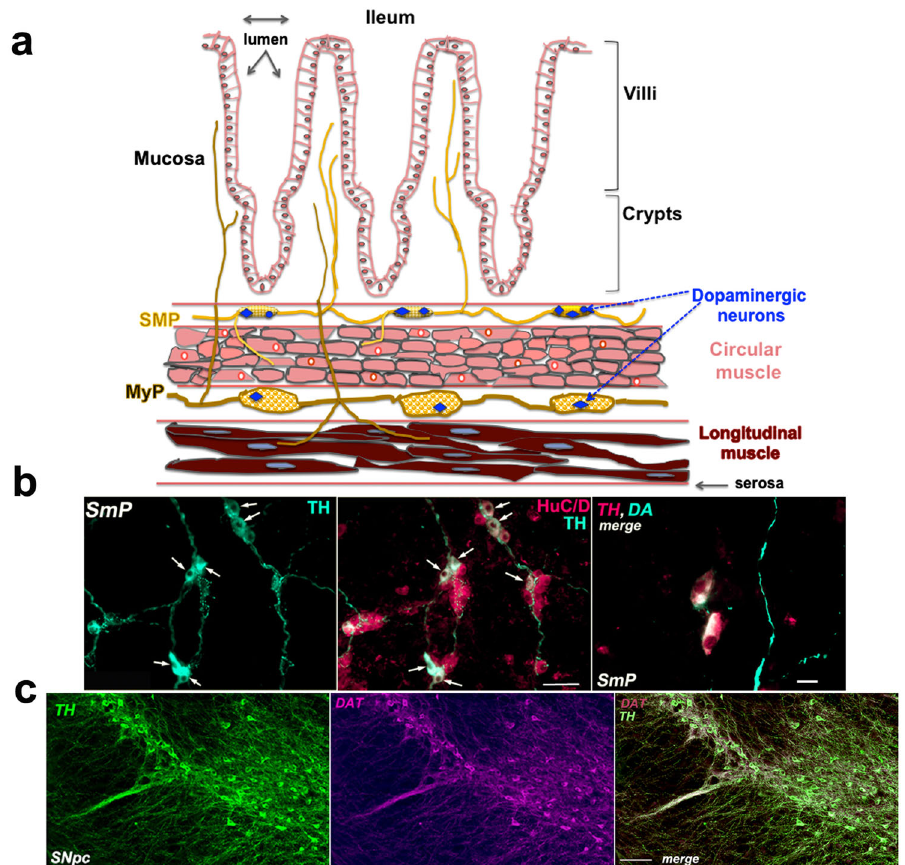
Fig. 1 Contrasting architecture of enteric dopaminergic neurons within enteric ganglia that are organized into two plexuses and of nigral dopaminergic neurons within layers of the SNpc. a Longitudinal section of gut through the ileum encompassing from the lumen to the serosa: the mucosal epithelial layer with villi and crypts, the submucosal layer with the ganglionic chains of submucosal (SMP) neurons (yellow), the layers (in cross-section) of circular smooth muscle fi bers (pink, brick-shaped), the ganglionic chains of myenteric (MyP) neurons (brownish yellow), the layers of longitudinal smooth muscles (dark red). Dopaminergic neurons within the ganglia of both plexuses are highlighted (blue stars). Note how the chains of submucosal ganglia are contiguous with the mucosa. b Fluorescence immunocytochemistry of representative whole mounts of SmP from adult mouse, displaying the dopaminergic neurons (left panel, identi fi ed with TH antibodies, green fl uorescence, white arrows) and as a subset (middle panel, merged image, white arrows) of all the neurons identi fi ed with HuC/D antibodies, (magenta fl uorescence); calibration bar: 70 microns. Right panel: magni fi ed view of two dopaminergic neurons identi fi ed with both TH and DA antibodies (merged magenta and green fl uorescences); calibration bar: 16 microns. This image is provided by Dr Alcmène Chalazonitis. c Fluorescence immunocytochemistry of a representative section of adult mouse midbrain through the Substantia Nigra with dopaminergic neurons identi fi ed with TH antibodies (left panel, green fl uorescence), DAT (middle panel, magenta fl uorescence) and merged image (right panel, green and magenta fl uorescences). Calibration bar: 100 microns. This image is provided by Benjamin Hobson from Dr David Sulzer ’ s